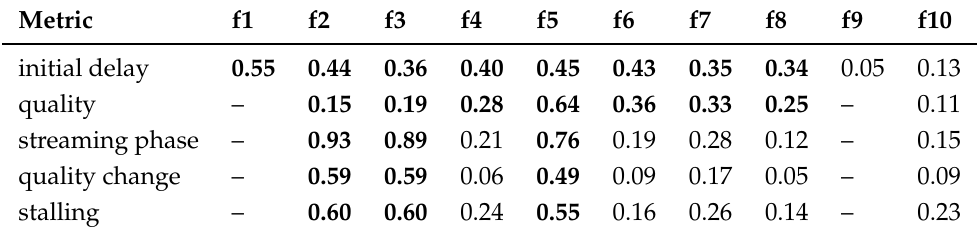
Table 8. Feature importance scores (high scores for selected feature sets in